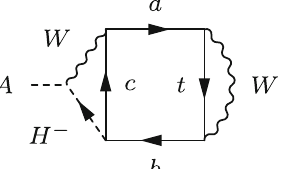
Fig. 5 The second set of relevant diagrams is generated from permuta- tions of the fermions in this diagram and by replacing the W -insertions with a Goldstone